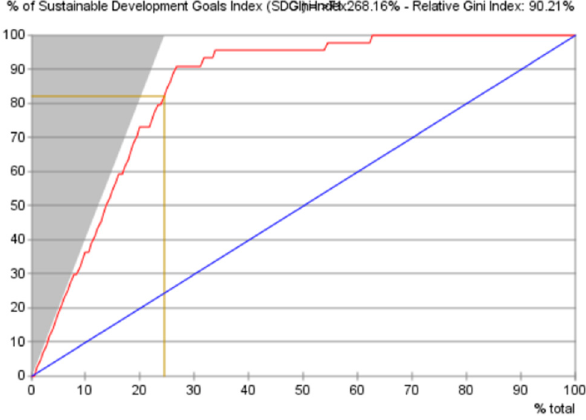
Figure 11. Gains curve.